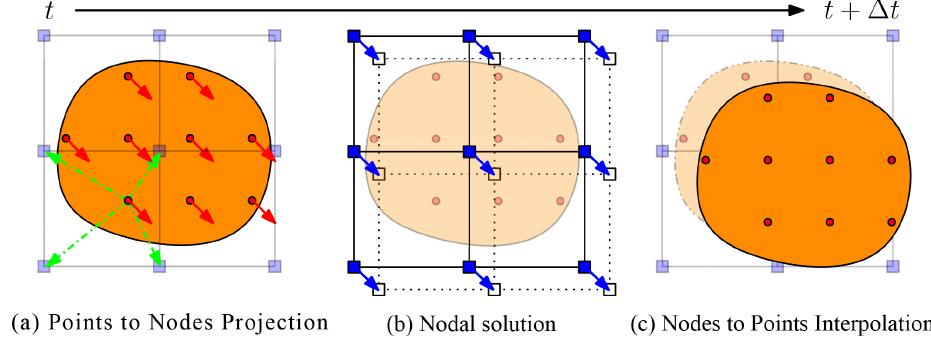
Figure 1. Typical calculation cycle of an MPM solver for a homogeneous velocity field, inspired by Dunatunga and Kamrin (2017). (a) The continuum (orange) is discretized into a set of Lagrangian material points (red dots), at which state variables or properties (e.g. mass, stress and velocity) are defined. The latter are mapped to an Eulerian finite element mesh made of nodes (blue square). (b) Momentum equations are solved at the nodes, and the solution is explicitly advanced forward in time. (c) The nodal solutions are interpolated back to the material points, and their properties are updated.